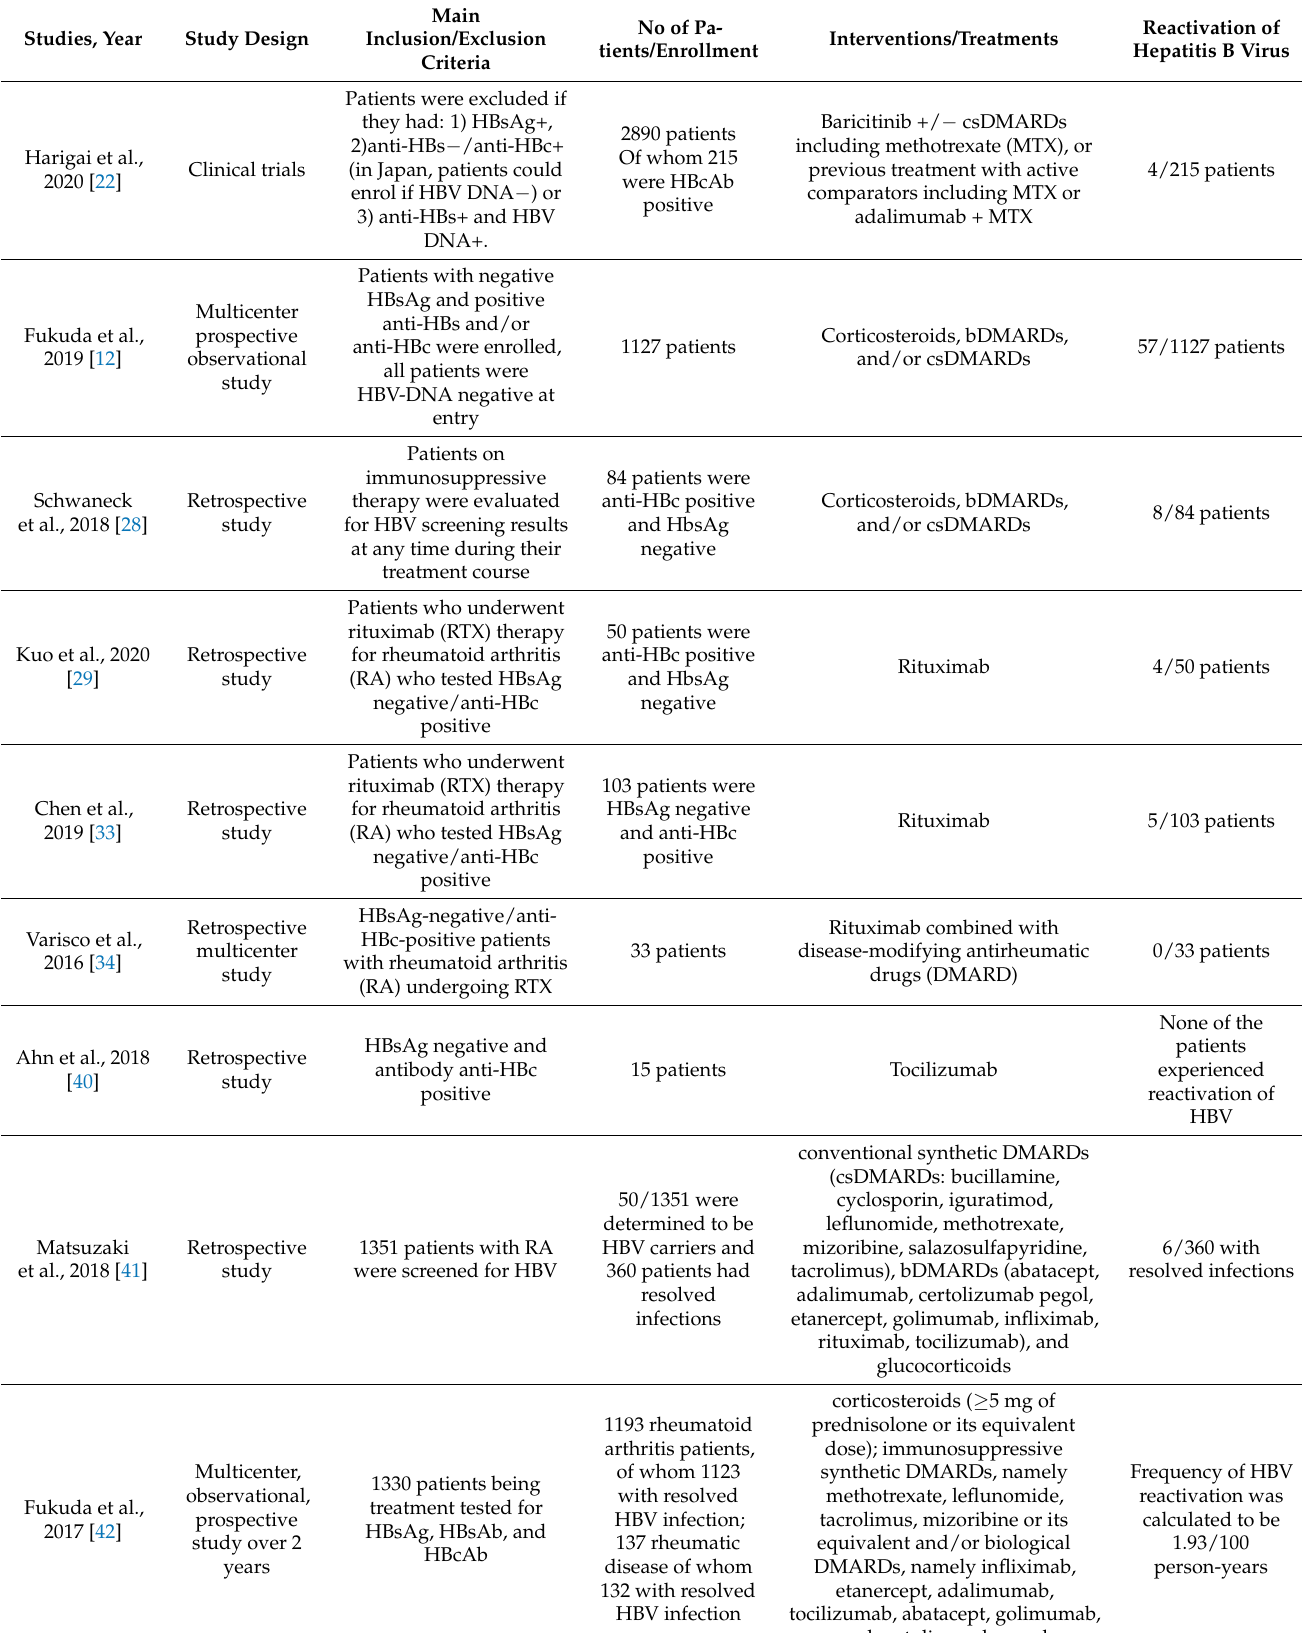
Table 1. Main studies on reactivation in occult HBV-infected patients treated with rheumatologic